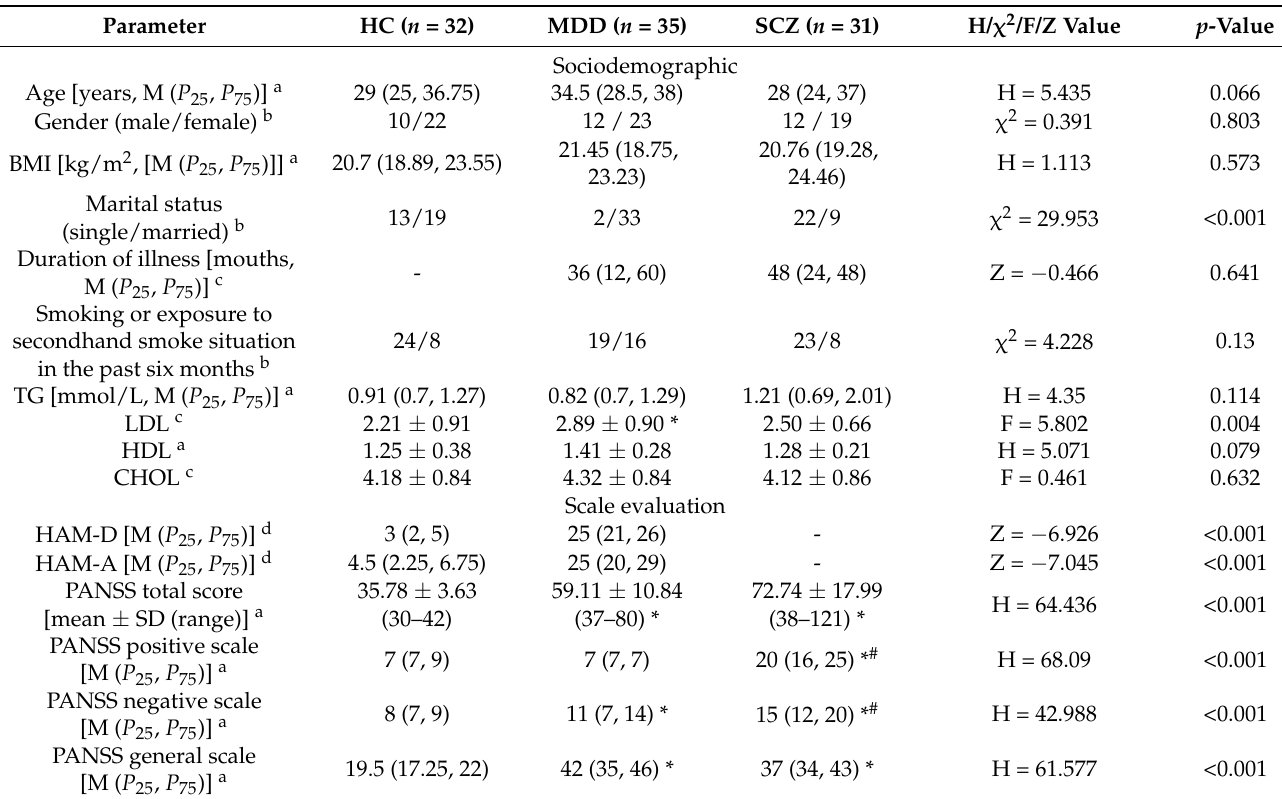
Table 1. The comparison of clinical characteristics and symptom scale assessment among HC, MDD, and